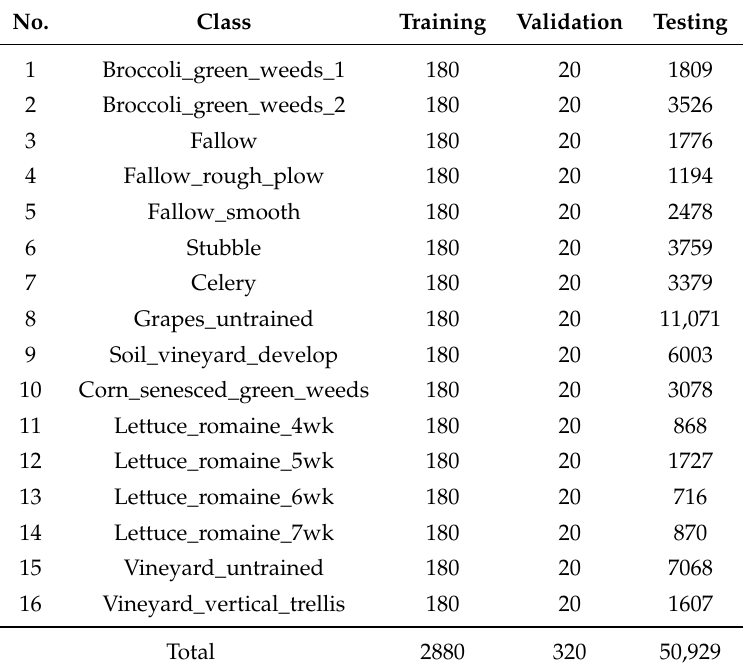
Table 4. Statistics of Training pixels, Validation pixels and Testing pixels for the Salinas DataSet.